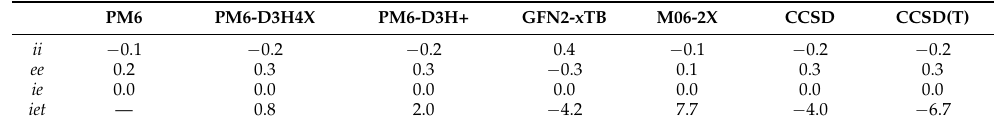
Figure 3. Energy (in kcal/mol) of the corannulene pincer conformers relative to ie . Table 2. Energy differences between conformers of the buckycatcher according to several methods. All values in kcal/mol. CCSD and CCSD(T) calculations evaluated on the PM6-D3H4X geometries, whereas the M06-2X calculations were performed on the GFN2-xTB geometries.